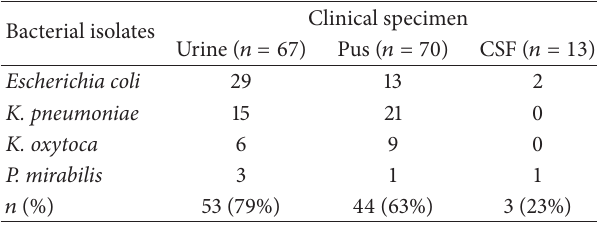
Table 1: Bacterial isolates from clinical specimens. Bacterial